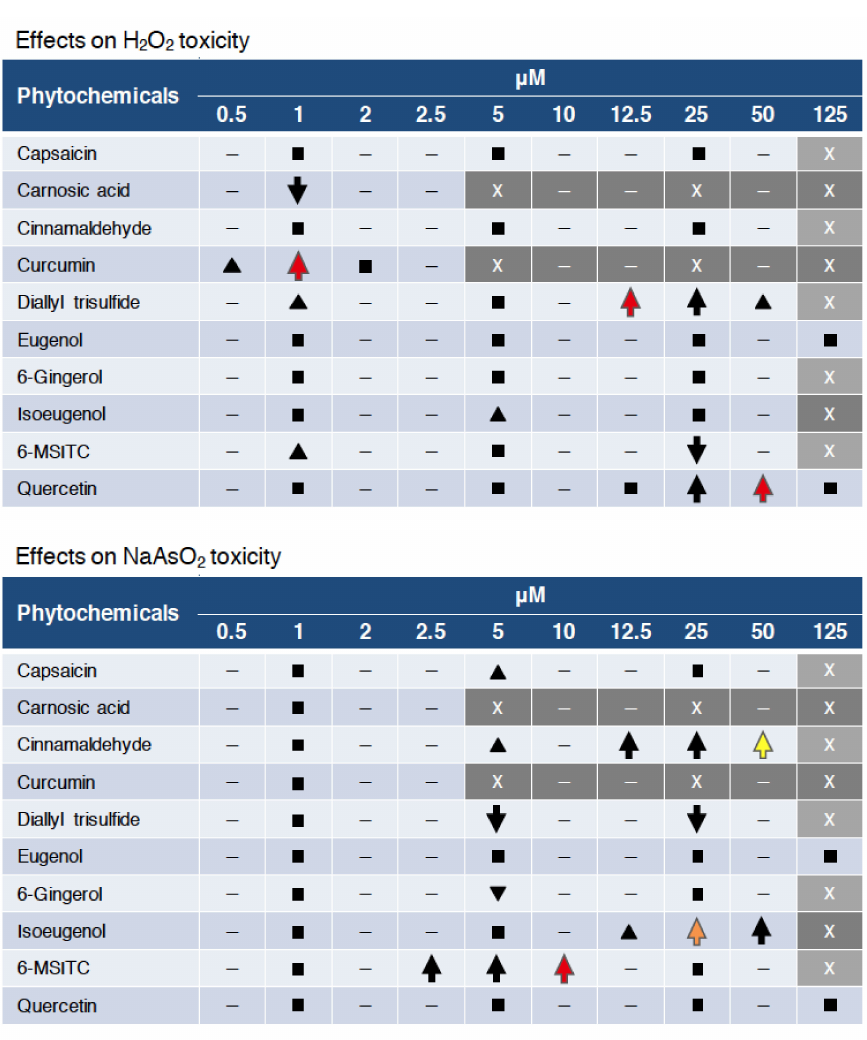
Figure 6. Summary of the e ff ects of phytochemical pretreatment. Up and down arrows denote the survival e ff ects, with a significant increase or decrease, respectively, in survival ( p < 0.05). Red, orange and yellow indicate Nrf2-depedent, partially Nrf2-depedent and Nrf2-independent activities, respectively. Black triangles denote a non-significant increase ( p < 0.1). Squares mean no significant e ff ects. “–” denotes “not analyzed”. “X” and gray background indicate toxic concentrations for each